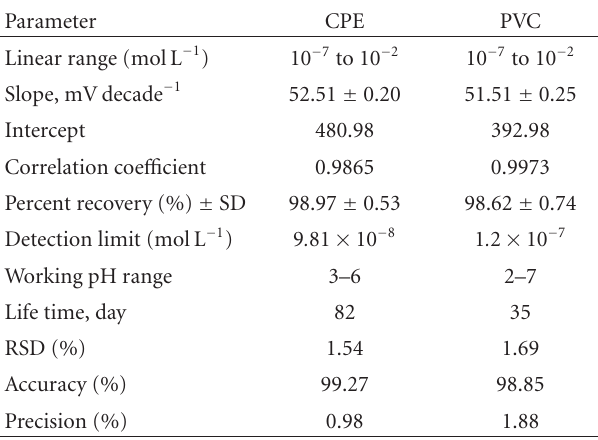
Table 2: Critical response characteristics of CPE and PVC